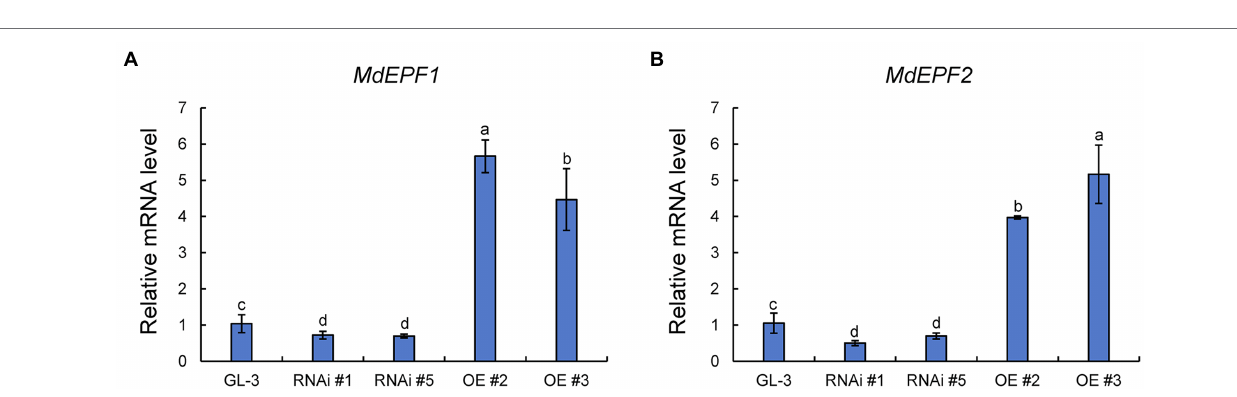
FIGURE 4 | Relative expression of MdEPF1 (A) and MdEPF2 (B) in the leaves of GL-3 and MdHB-7 transgenic plants. Data are presented as means ± SD ( n = 3). Different letters indicate significant differences based on one-way ANOVA and Tukey’s multiple range tests ( p <